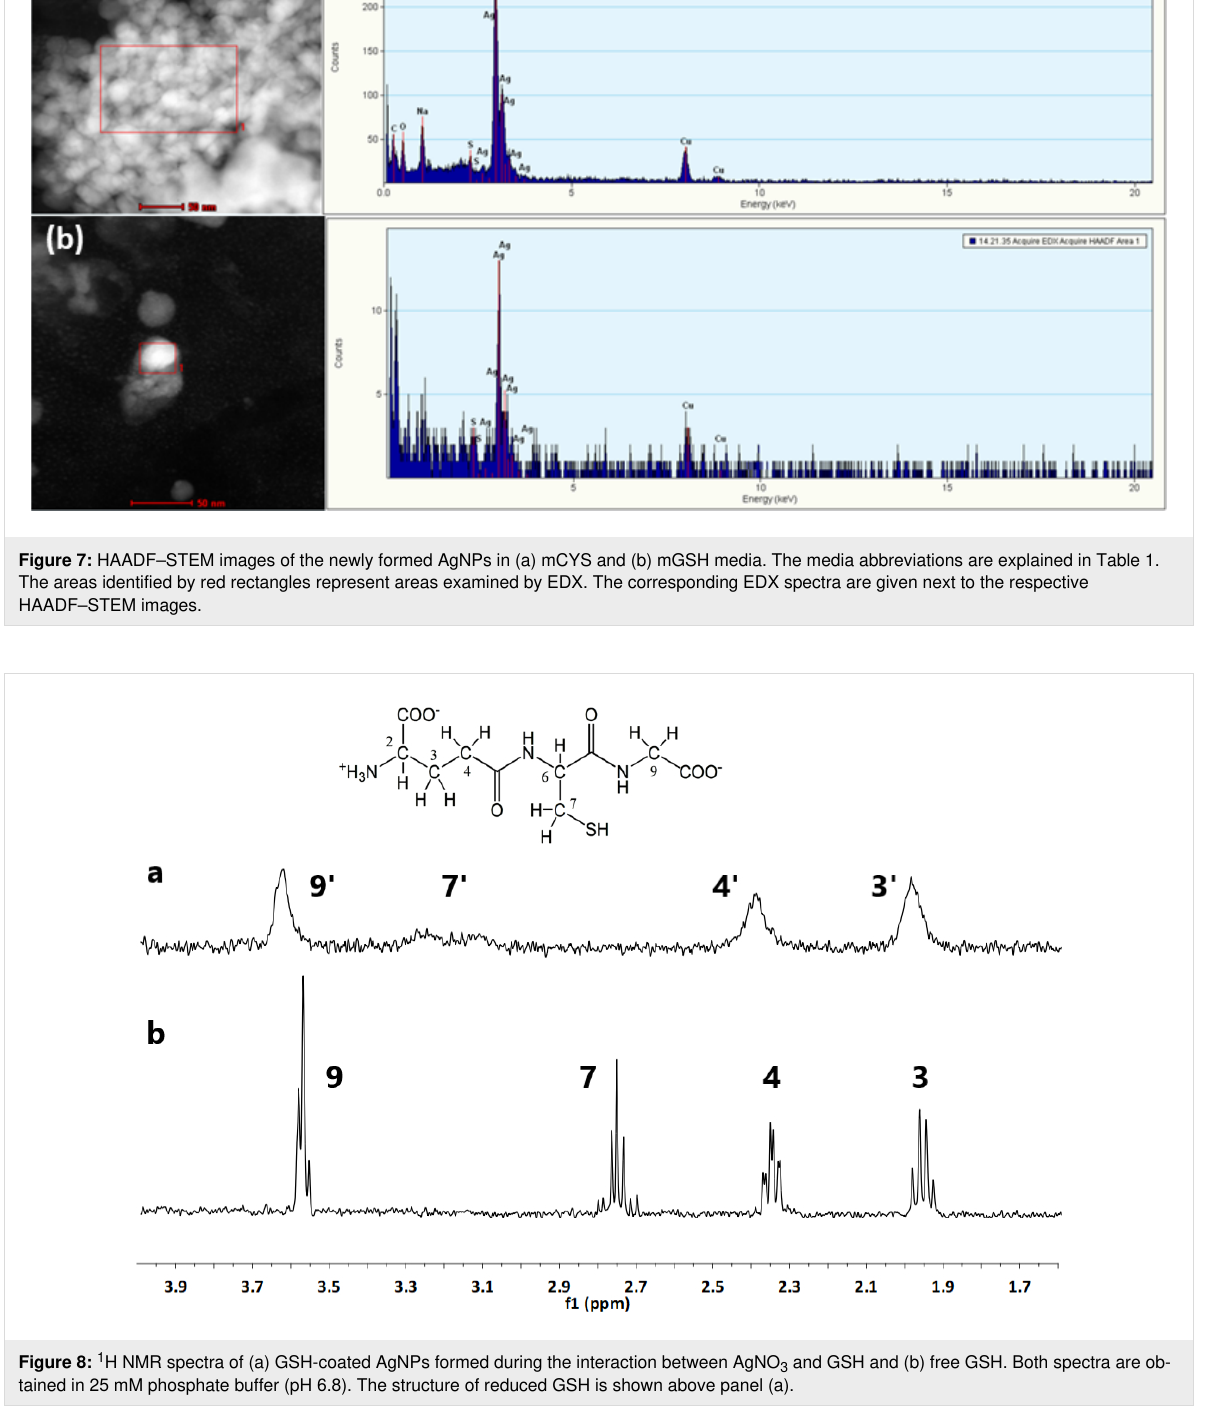
was conducted in 25 mM of PB to maintain the pH close to neutral, since the synthesis does not progress in water due to the acidic nature of